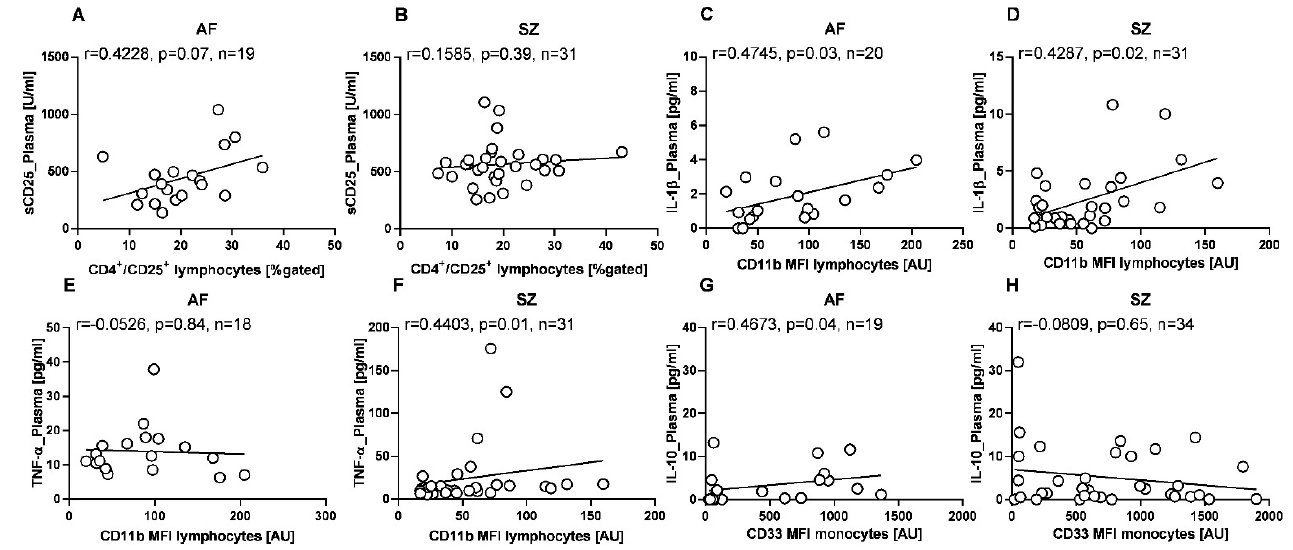
Figure 6. Correlation patterns for selected cytokine concentrations and immune phenotypes, in patients with AF and SZ. Shown correlations are CD4 + /CD25 + lymphocyte counts vs. sCD25 plasma concentrations for AF and SZ ( A , B , respectively), CD11b lymphocyte expression densities vs. IL-1 β plasma concentrations for AF and SZ ( C , D , respectively), CD11b lymphocyte expression densities vs. TNF- α plasma concentrations for AF and SZ ( E , F , respectively), and CD33 monocyte expression densities vs. IL-10 plasma concentrations for AF and SZ ( G , H , respectively). Expression densities are given as arbitrary units (AU), and cell counts are given as %-gated cells. Data are presented as scatter plots, with the line representing the linear regression fit, and r indicating the Spearman correlation coefficient. Shown correlations present relations in the majority of the investigated cohort, yet in some figures, individual outlier values were excluded from the correlation analysis.